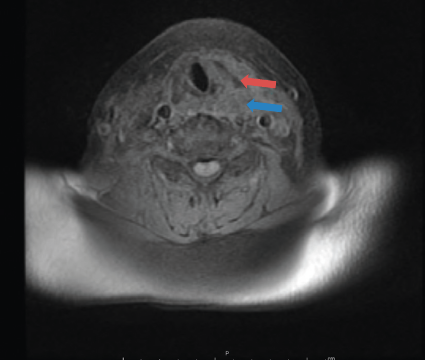
Figure 2: Neck RMI (T1) showing a left capsular lesion posterior to the thyroid gland (blue arrow), with hemorragic laryngeal in- filtration (red arrow).